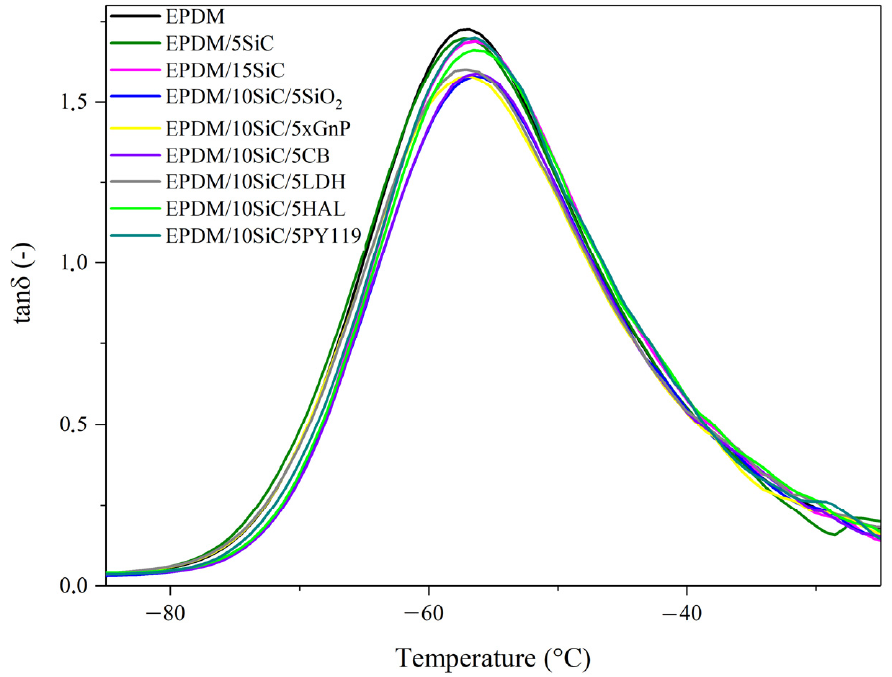
Figure 8. Tan δ versus temperature curves from DMA measurements for EPDM-filled composites. Table 3. Glass transition temperatures (Tg) and maximum tan δ values for different EPDM composites in DMA measurements.